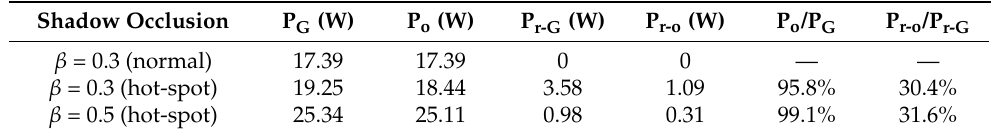
Table 3. Simulation data of the hot-spot control algorithm under different β . Shadow